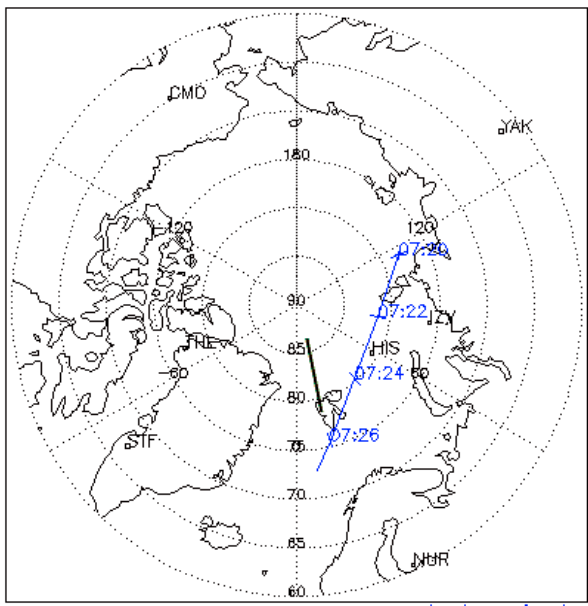
Fig. 4. Map over the northern polar cap showing the F13 footprint between 07:20 and 07:27UT, as well as the field of view of the 32- meter ESR